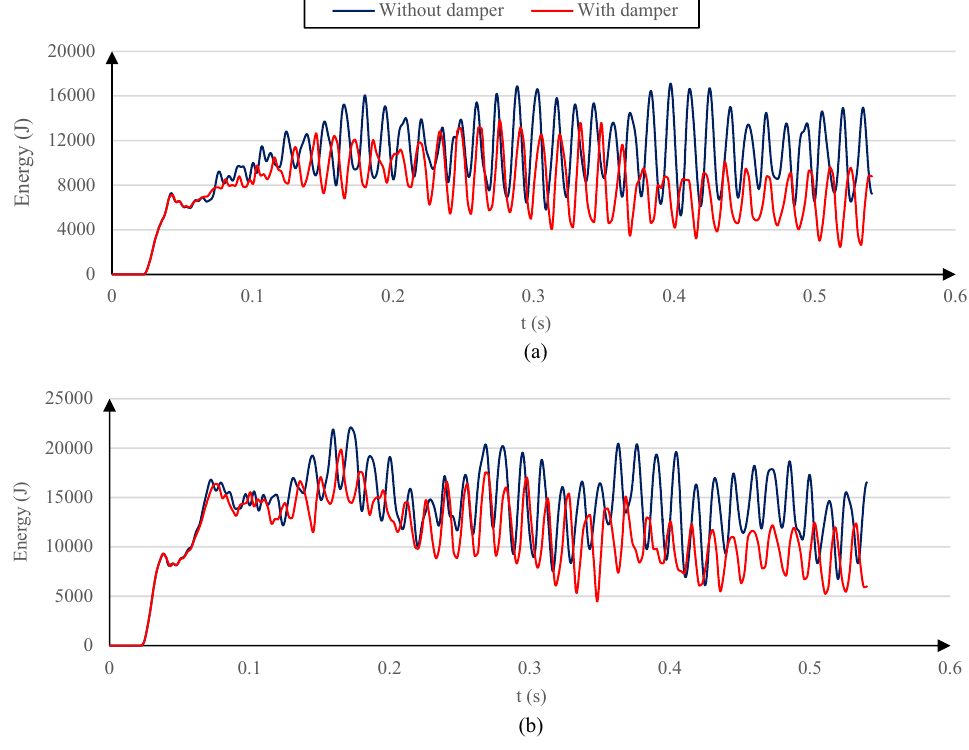
Figure 3. Model ( a ) kinematic and ( b ) strain energies, with and without the proposed damping mechanism.